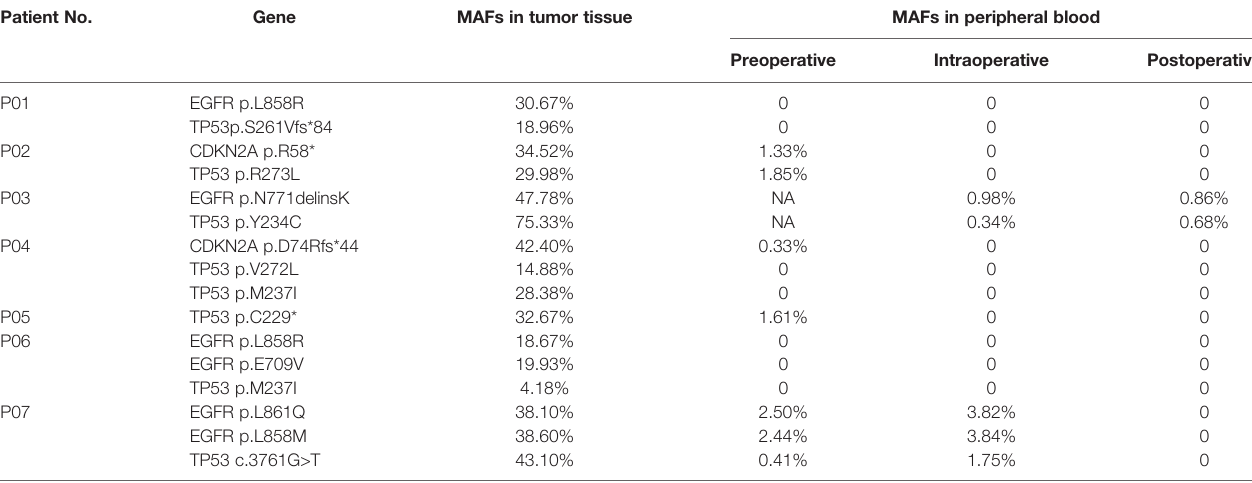
TABLE 3 | NGS 23-gene panel detection results. Patient